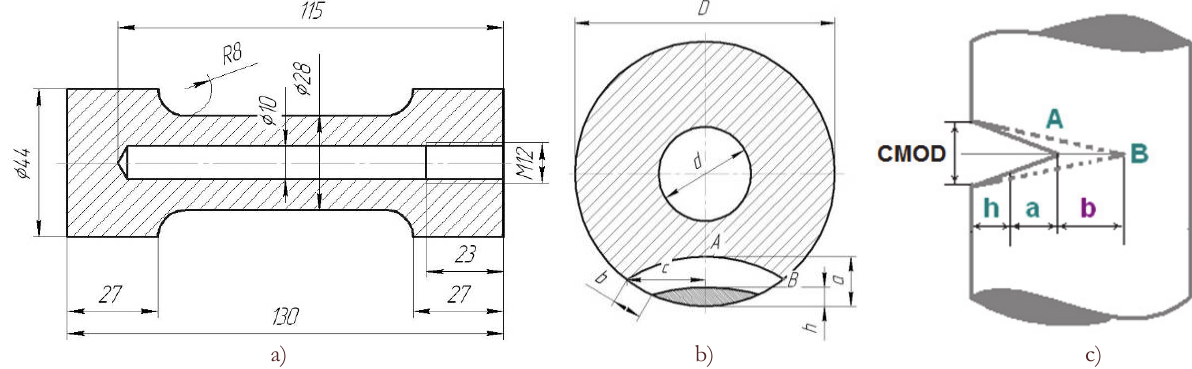
Figure 1: Details of the hollow specimen geometry and initial